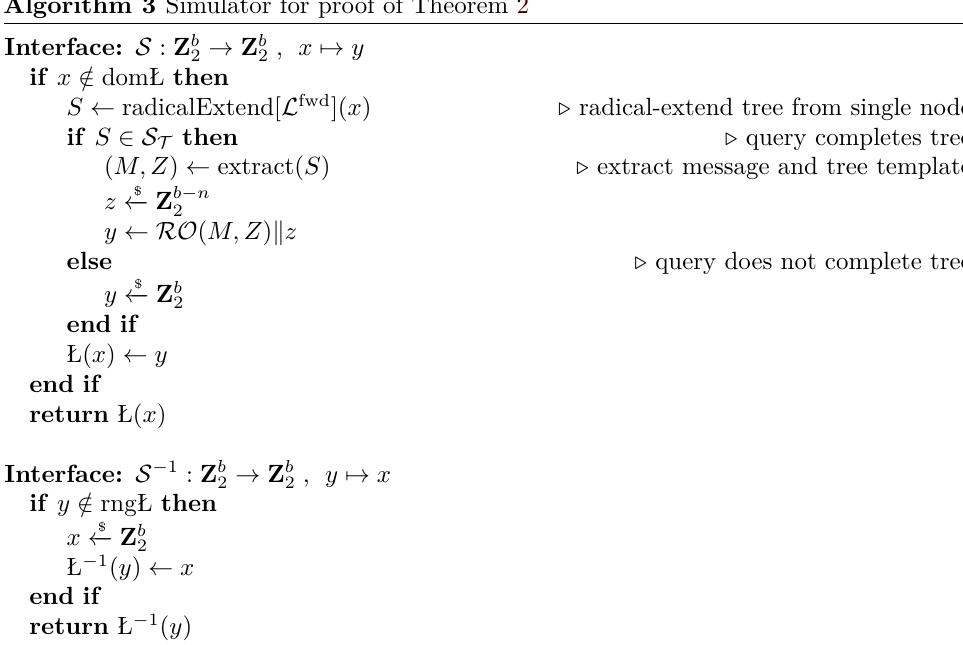
Algorithm 3 Simulator for proof of Theorem